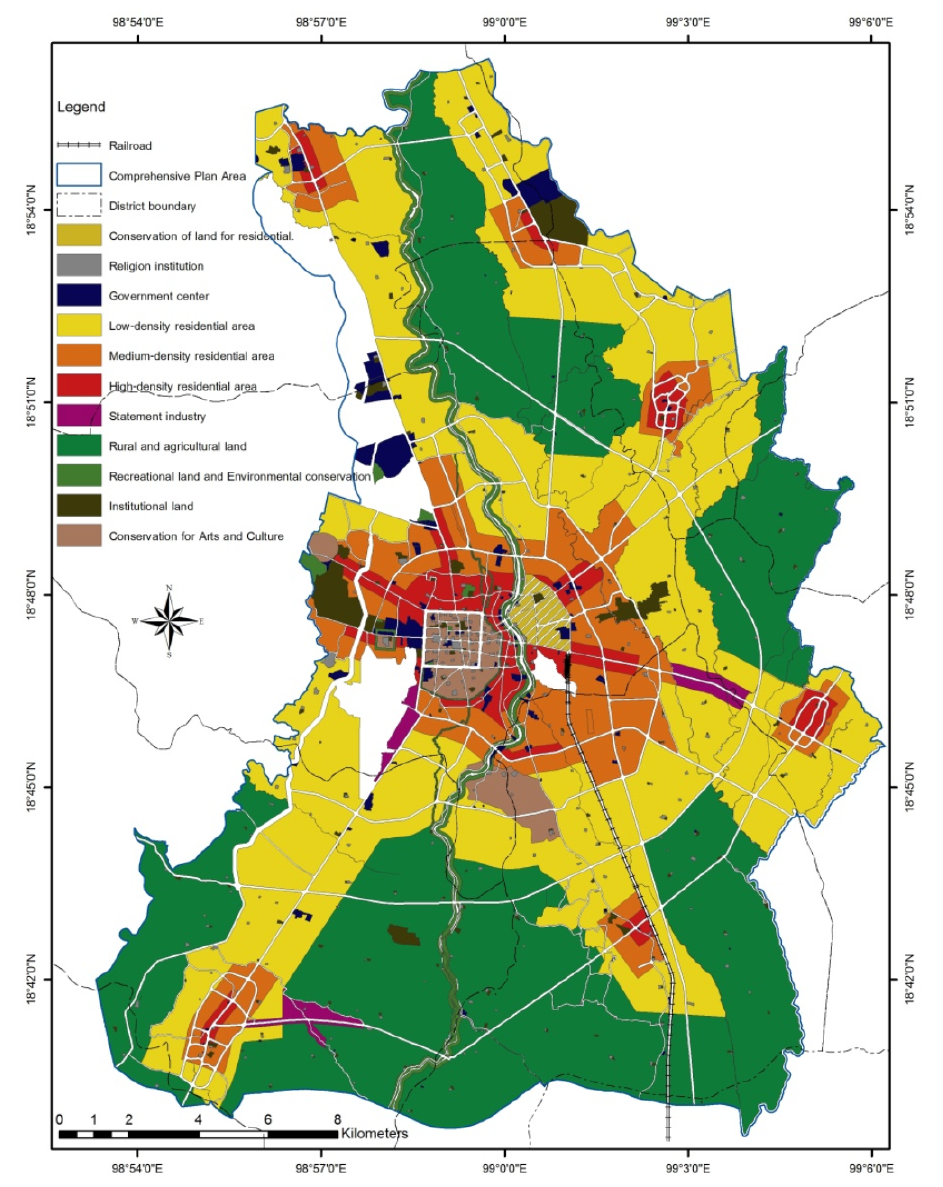
Figure 5. Eleven land use zones in the 3rd revision of the Chiang Mai Comprehensive Plan. The outer ring road passes through wedges of agricultural conservation zones, yet is triggering uncontrolled development. Six older town centers are planned for higher density development along radial roads, but most high density residential and commercial spaces are emerging at the intersections of the superhighway and ring roads and the radial roads producing unplanned centers. Adapted from Department of Public Works and Town & Country Planning